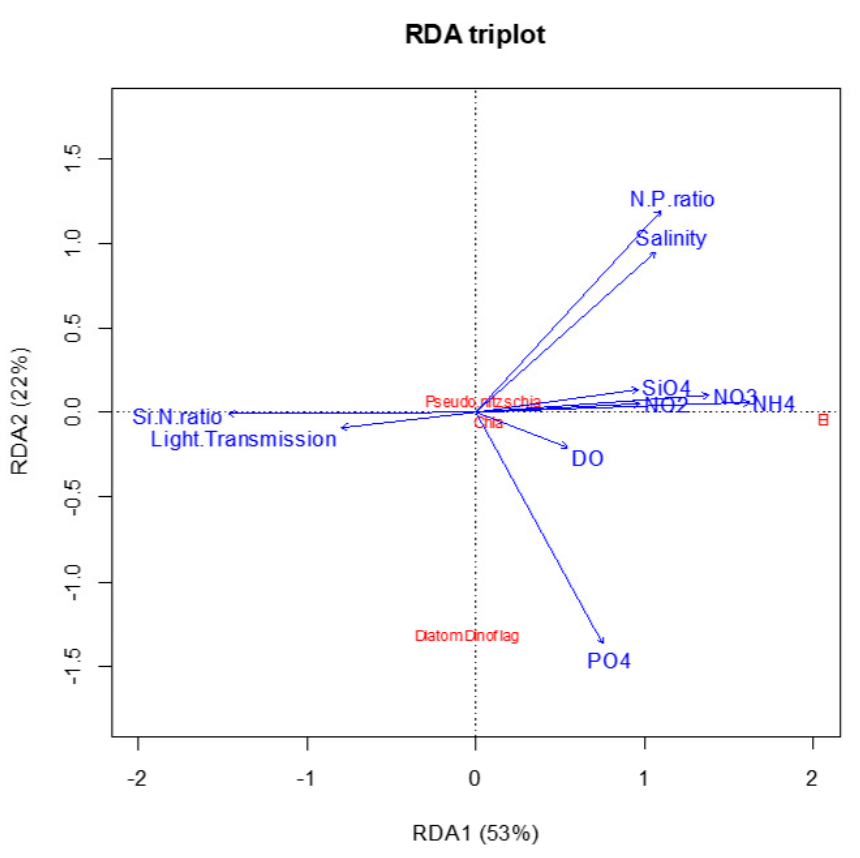
Figure 6. Triplot of Redundancy Analysis